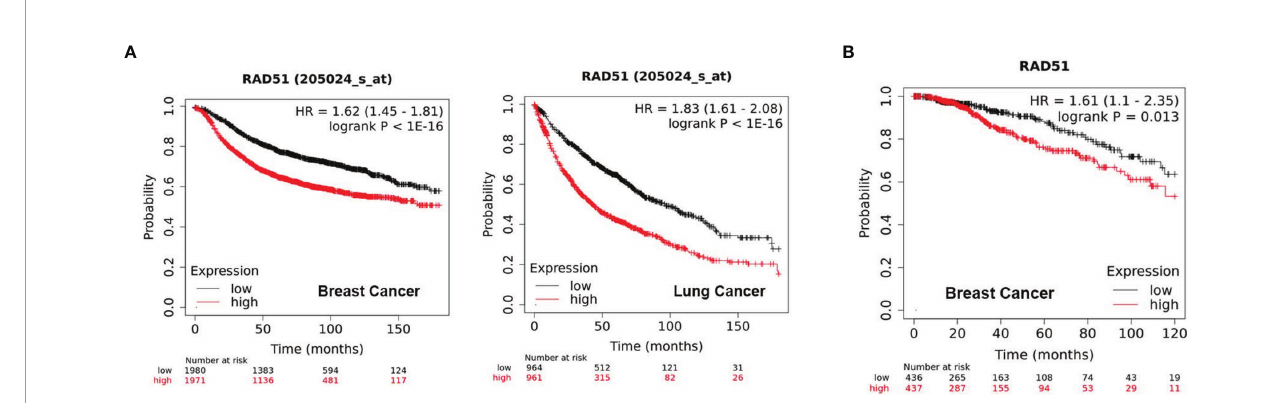
FIGURE 1 | High RAD51 expression is associated with poor clinical outcome. (A) Kaplan-Meier Plots showing the probability of relapse-free survival (RFS) in breast cancer patients (n = 3951, left) and overall survival (OS) in lung cancer patients (n = 1925, right), who were strati fi ed by the median of RAD51 gene expression. (B) Kaplan-Meier Plots showing the probability of OS in breast cancer patients (n = 873), who were strati fi ed by the median of RAD51 protein expression. P value was calculated using the log-rank